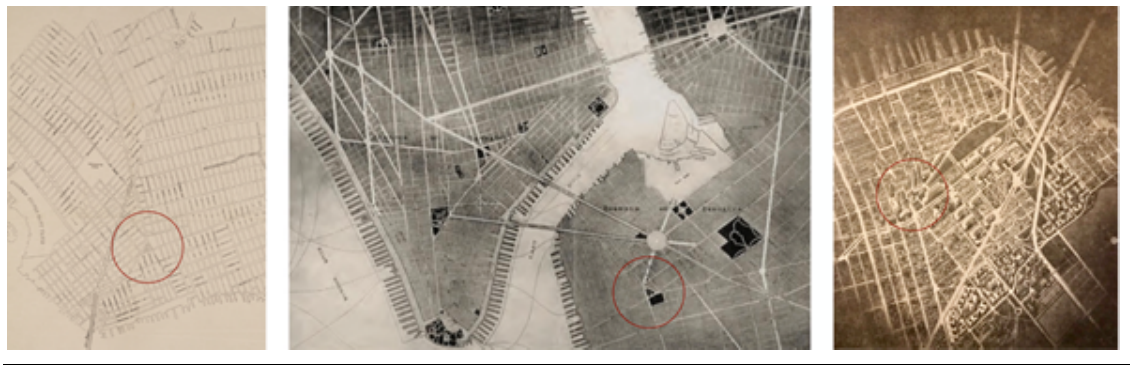
Figure 10. Urban plans focused on connectivity, including, left: ca. 1900 plan to connect the Brooklyn Bridge directly to Flatbush Ave; centre: 1907 commission plan that includes a major roundabout and radiating avenues at the convergence of the Brooklyn and Manhattan Bridges; right: the largely realised 1944 new Civic Centre Plan. (Sources: New York Public Library, Internet Archive/Cornell University